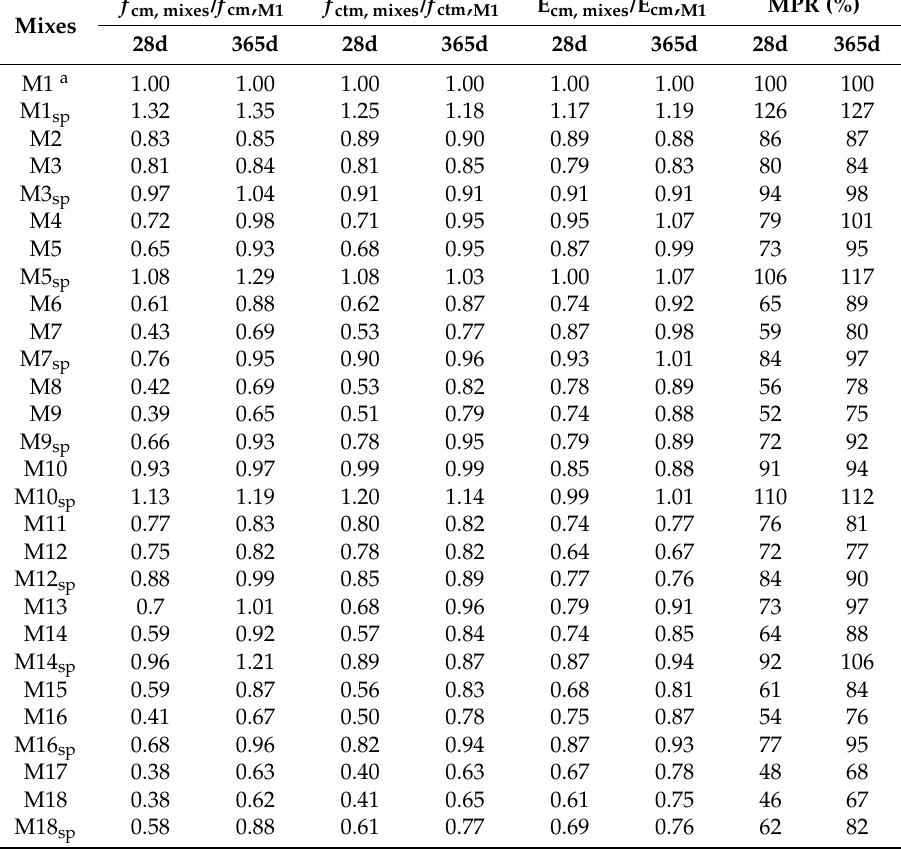
Table 3. Compressive strength ( f cm ), splitting tensile strength ( f ctm ), and modulus of elasticity (E cm ) of non-conventional concrete mixes relative to the reference concrete; MPR: mechanical performance